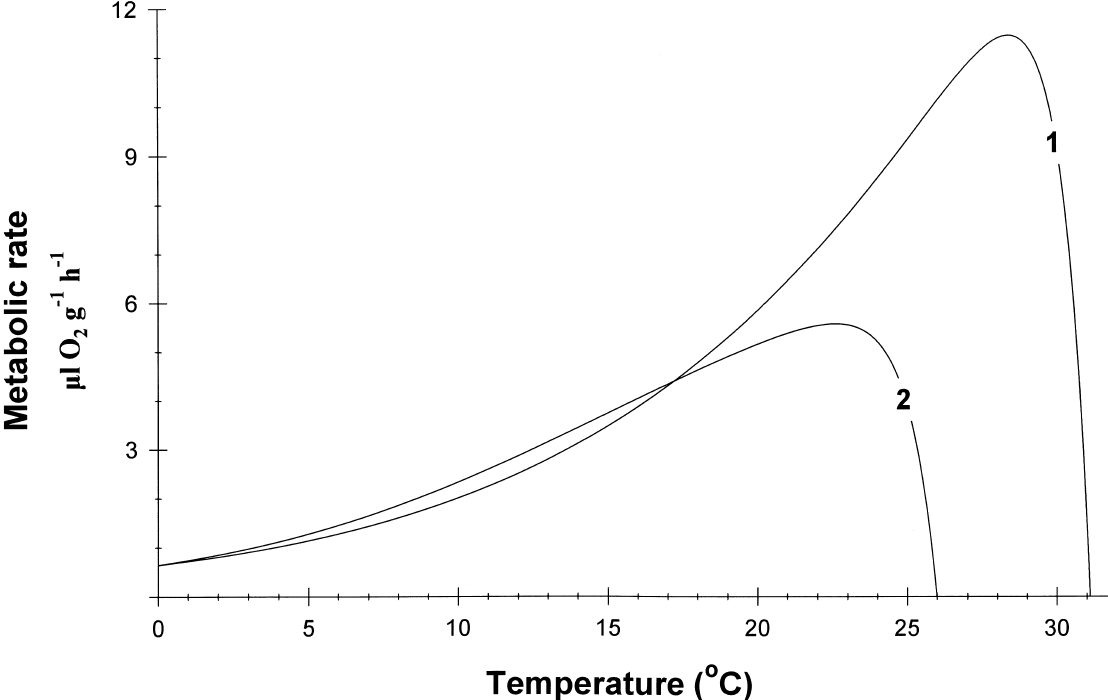
Fig. 3. Relationship of metabolic rate to temperature in adult G. balcanica . 1: specimens fed on non-contaminated food, 2: specimens fed on contaminated